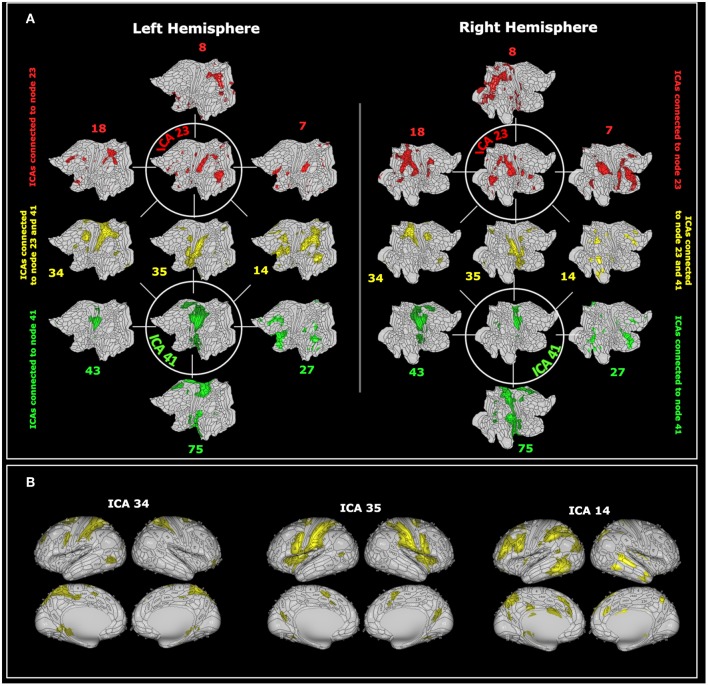
(A) The visuospatial-emotional network centered about ICA 23 (in green) and the vestibular-navigational network centered about ICA 41 (in red) are superimposed on flat brain (66). The visuospatial-emotional network was strongly connected with regions 18, 8, 7, whereas the vestibular-navigational network was connected with regions 43, 75, 27. The two networks overlapped at nodes 34, 35, and 14 (in yellow). (B) The shared nodes are depicted again superimposed on the inflated brain (66). For visualization purposes we only reported the 6 nodes most closely connected to ICA 23 or 41. ICAs include values higher than the 98'th percentile.